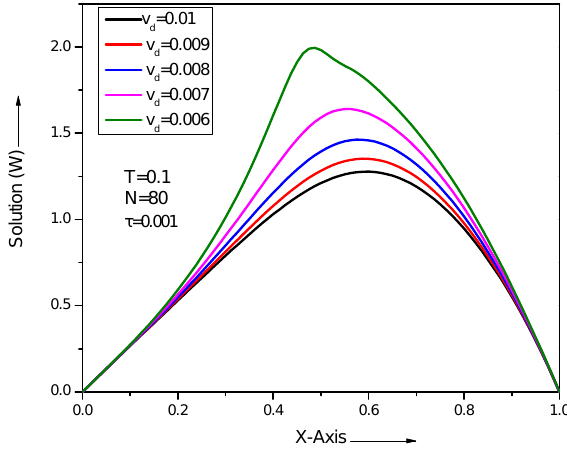
Figure 9. Numerical results with different ν d and ∆ x = 0.0125, τ = 0.001 at time T = 0.1 for problem